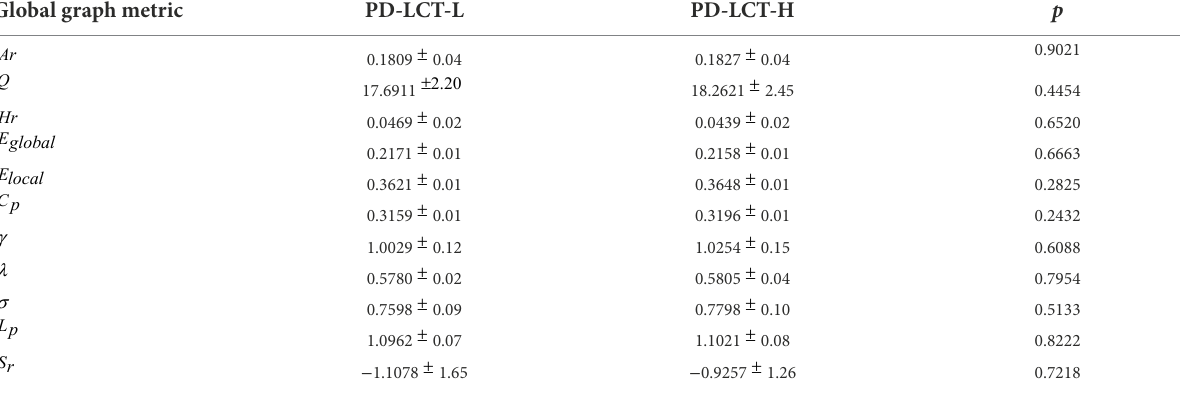
TABLE 2 Global and local graph metrics of the brain